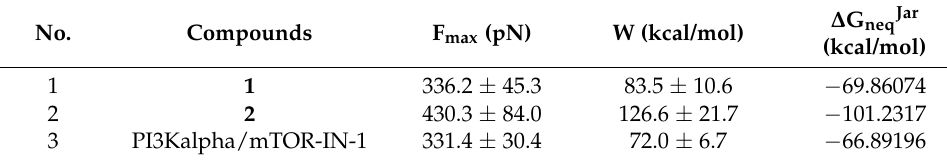
Table 2. SMD Results from 20 independent